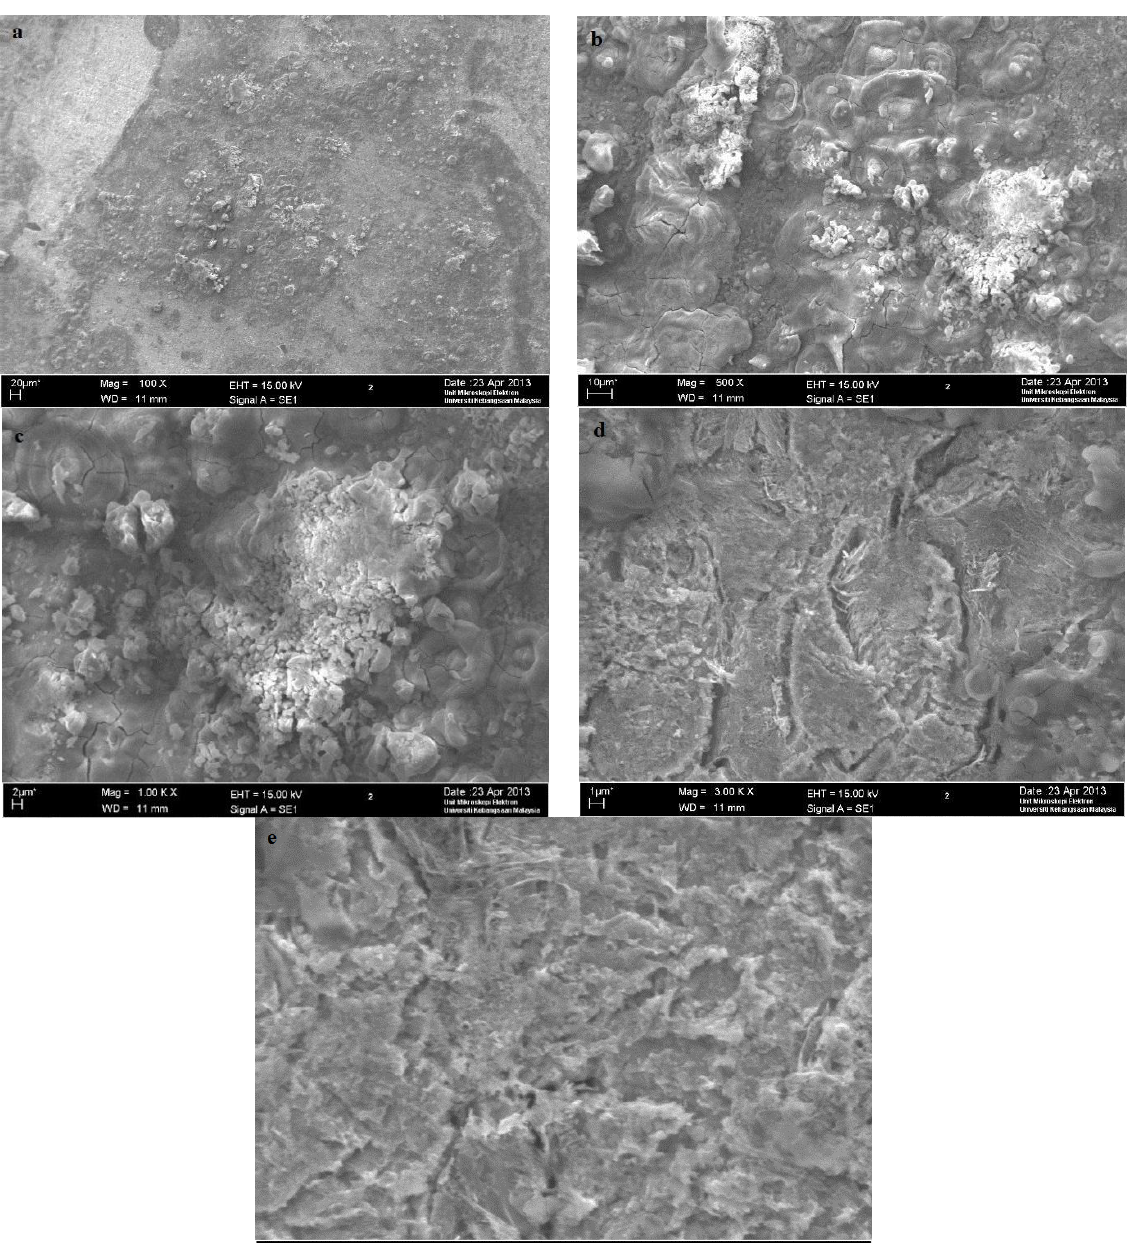
Figure 8. The SEM micrographs for mild steel in 1.0 M H inhibitor at 30 °C. ( a ) 100×; ( b ) 500×; ( c ) 1000×; ( d ) 3000×; ( e )